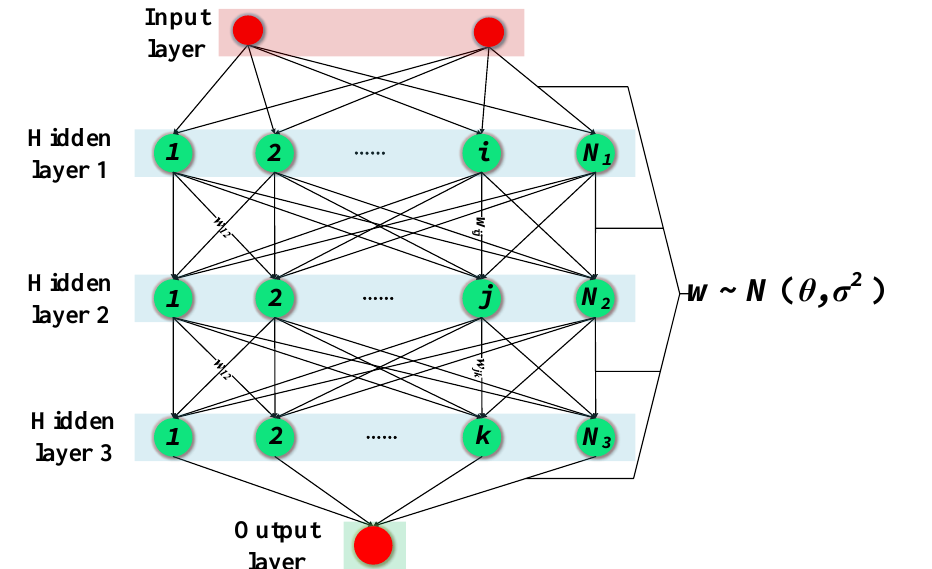
Figure 1. Network structure of variational Bayesian neural network (VBNN).